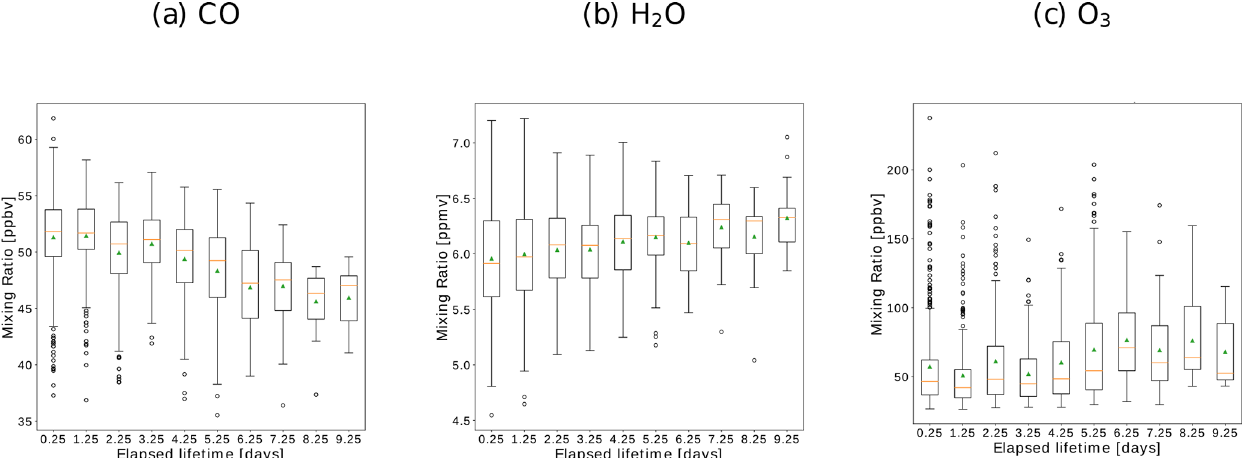
Figure 9. Chemical evolution of the chemical species of (a) CO, (b) H 2 O, and (c) O 3 within the exemplary PV cutoff of Fig. 3. The box- and-whisker plots show the upper and lower quantile, the median (orange line), and the average (green pyramid) of the mixing ratios for each time step during the lifetime of the PV cutoff cascade. The black dots show the